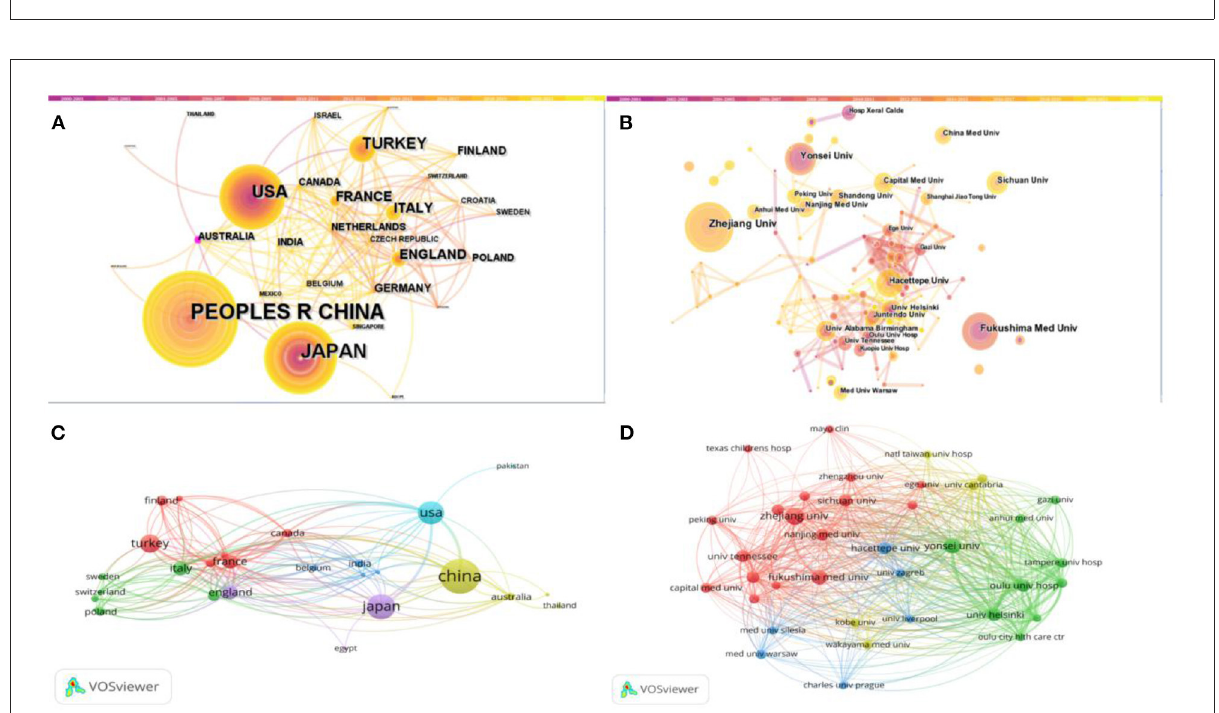
FIGURE2 Analysis of the countries and institutions. (A) CiteSpace network map of countries involved in IgAVN in Children. (B) CiteSpace network map of institutions involved in IgAVN in Children. (C) VOSviewer network map of countries involved in IgAVN in Children. (D) VOSviewer network map of institutions involved in IgAVN in Children. Peoples r china and taiwan were replaced by China; united states was replaced by USA; north ireland, wales, england and scotland were replaced by